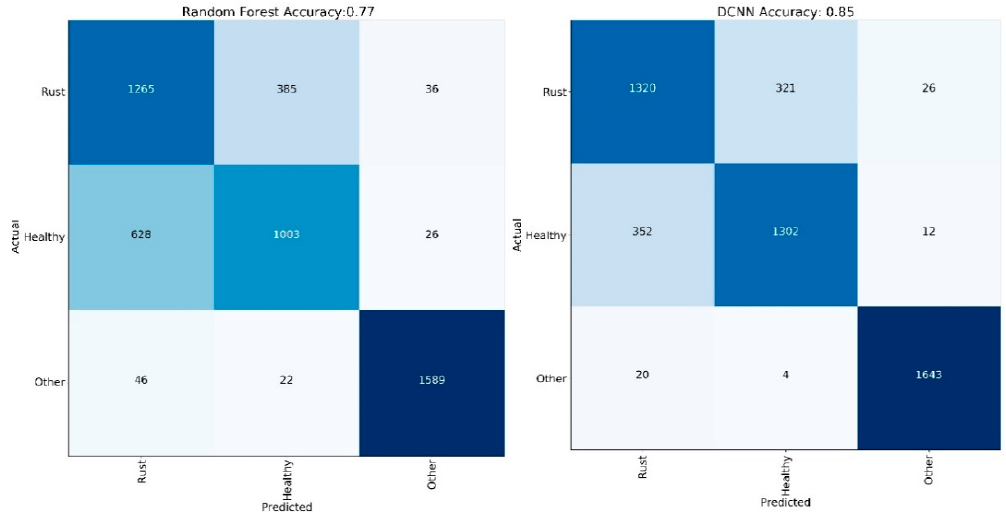
Figure 8. The classification accuracy and confusion matrix of the random forest classification method and the proposed DCNN model on a test dataset of 5000 blocks.